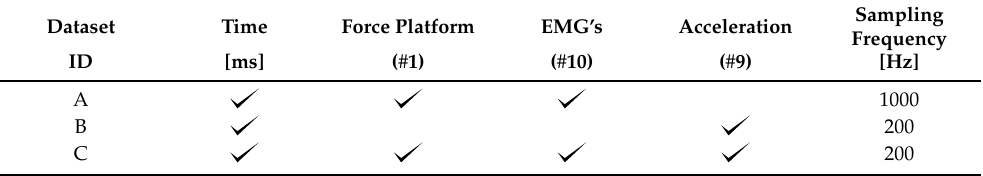
Table 3. Overview of the three types of datasets analyzed. Dataset Time Force Platform EMG’s ID [ms] ( # 1) [Hz] A 1000 B 200 C 200 (# val) number of sensors.